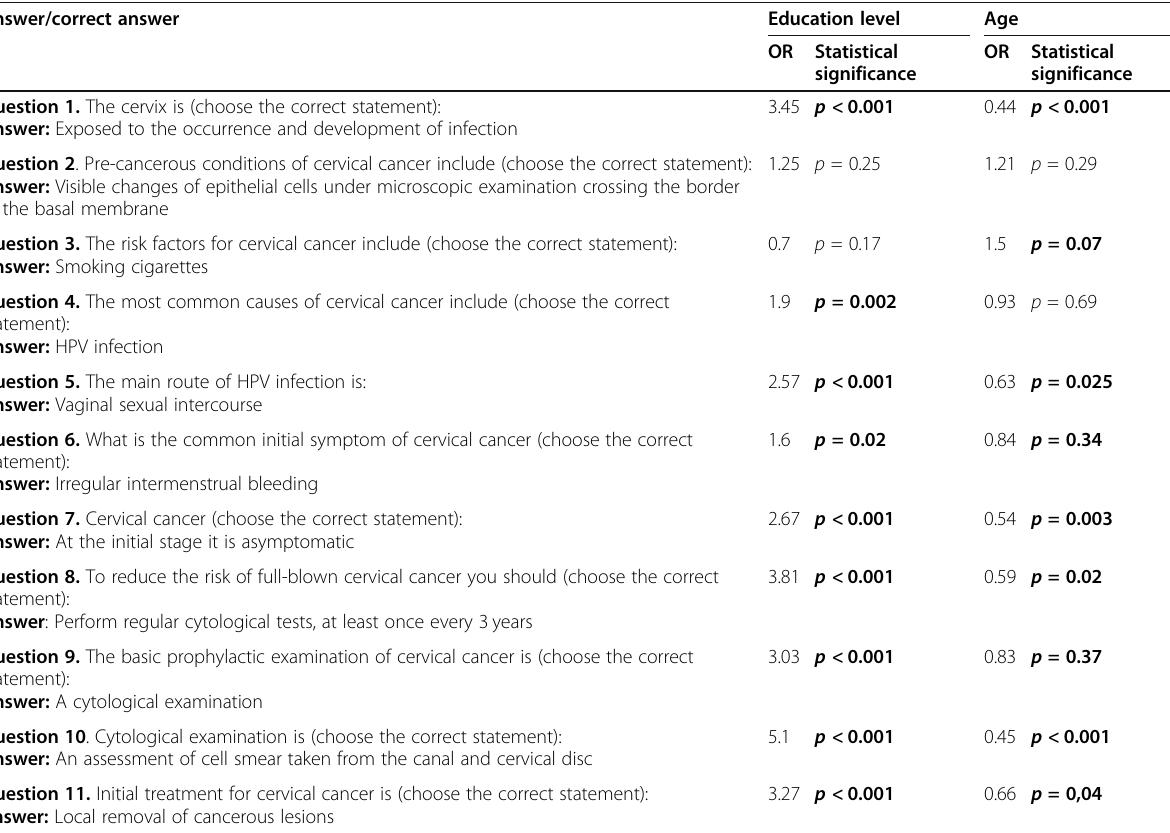
Table 4 Summary of logistic regression models for answers from the questionnaire (0 — false, 1 — true) as a dependent variable and education level and age as independent